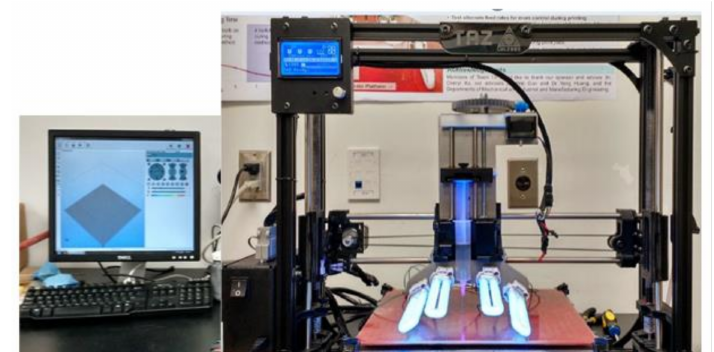
Figure 6. 3D-printing experimental setup.